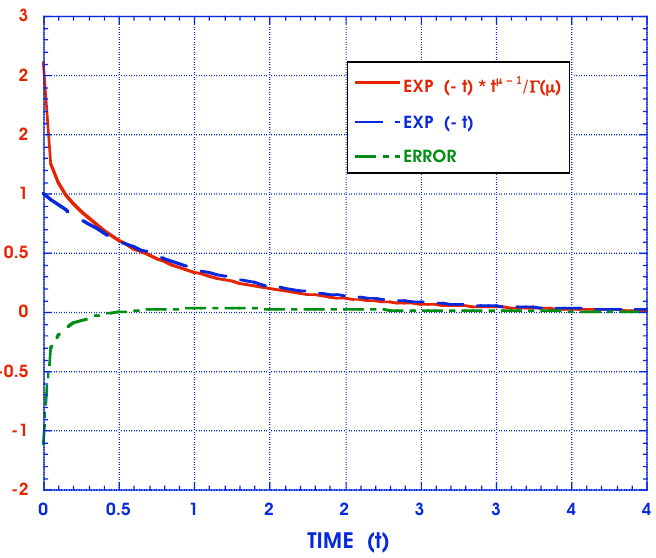
Figure 9. Comparison of ID and approximate